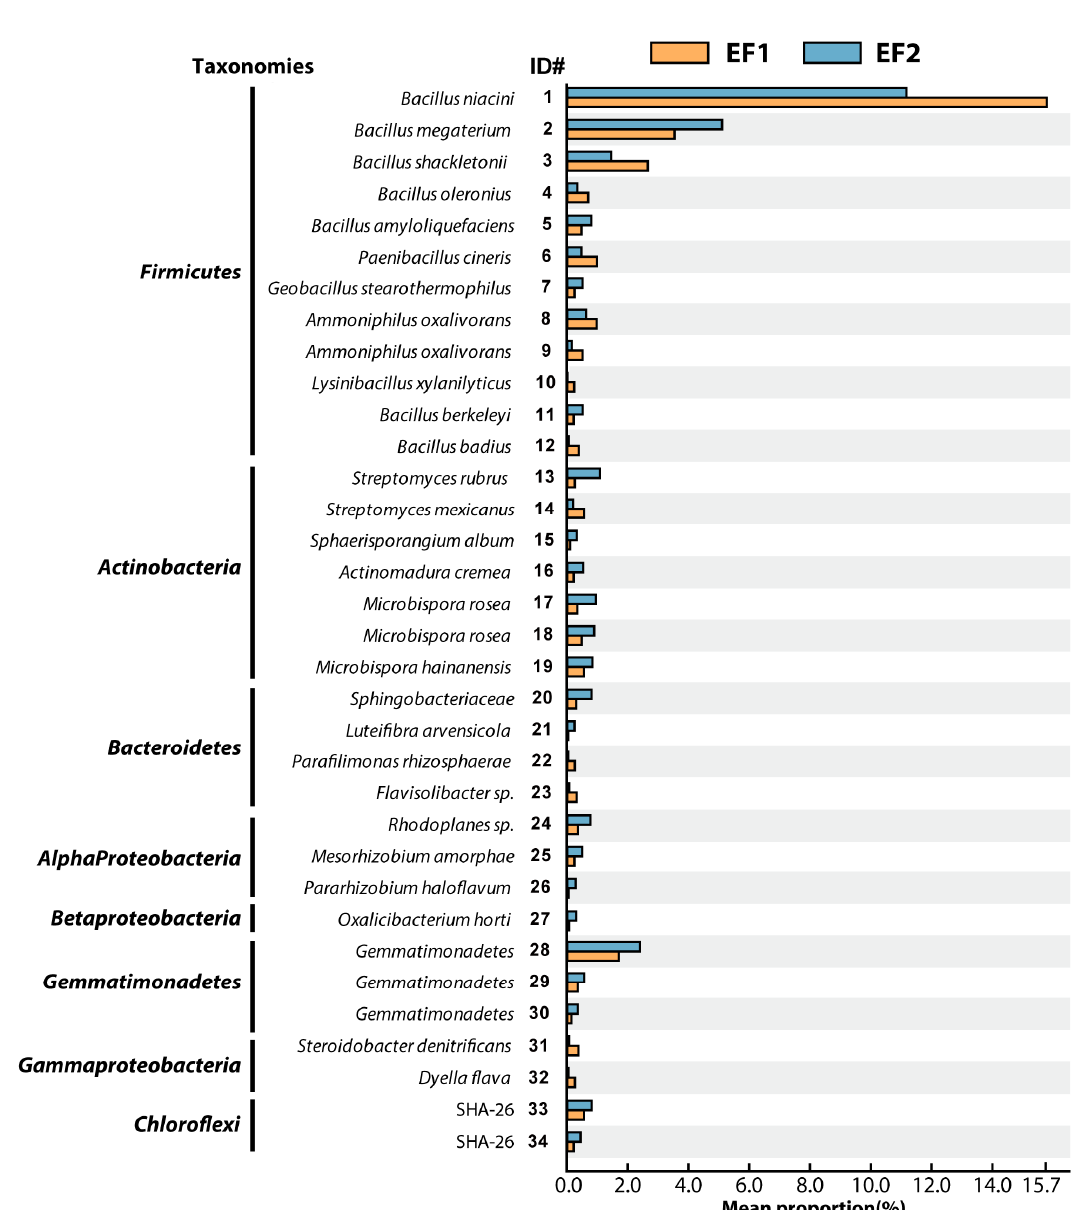
Figure 3. Extended error bar plot with significantly different phylotype abundances ( p < 0.05) between experimental fields (EF) 1 and EF2.